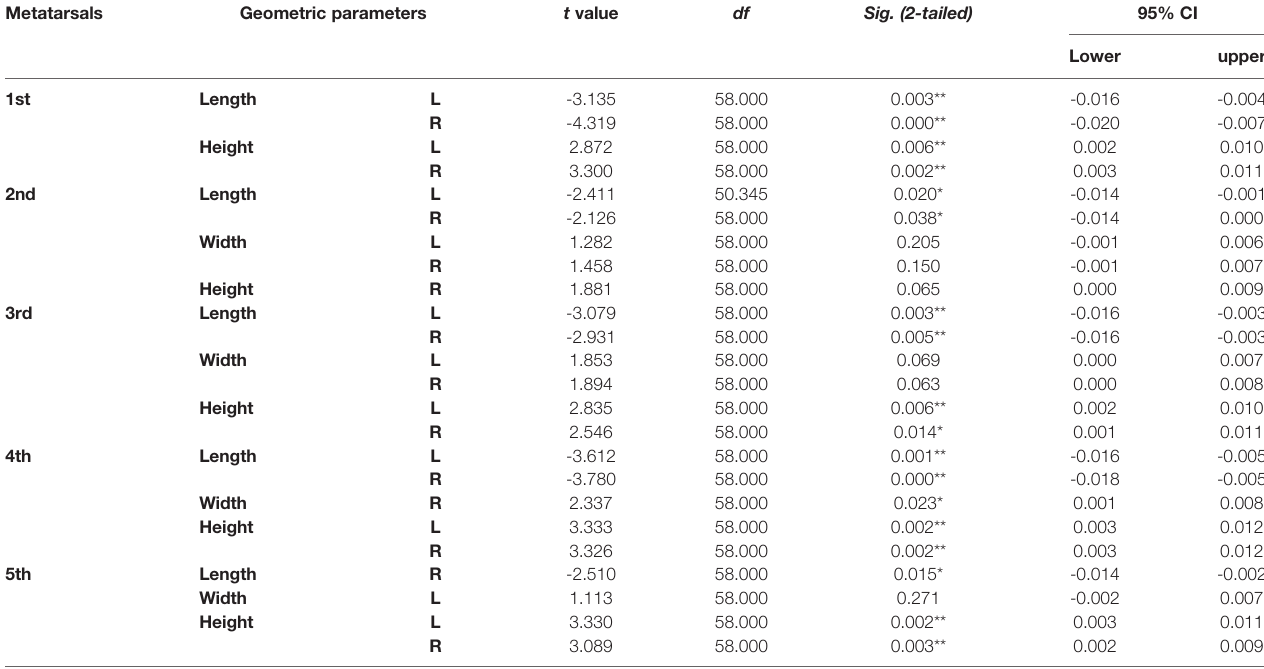
TABLE 4 | Independent sample t -test results of normalized length, width, and height of metatarsal bone in vivo based on its PAI between sexes. Metatarsals Geometric parameters